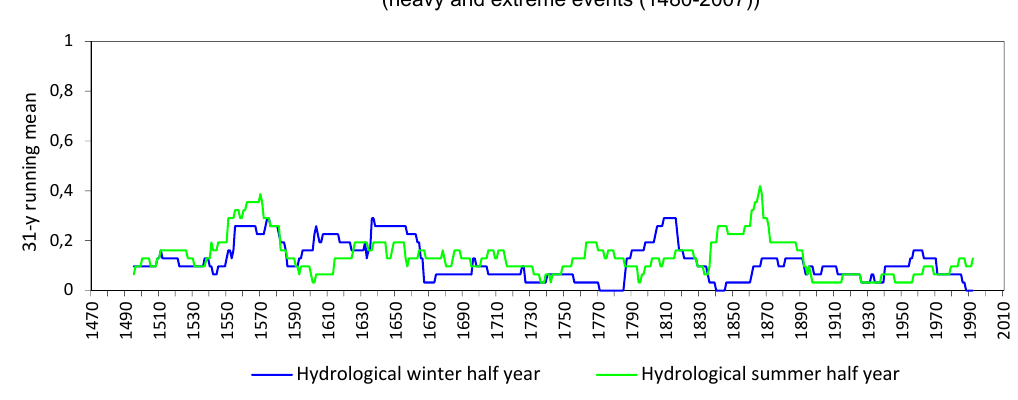
Figure 9. Floods of the River Rhine in the hydrological summer and winter years (big and extreme events).